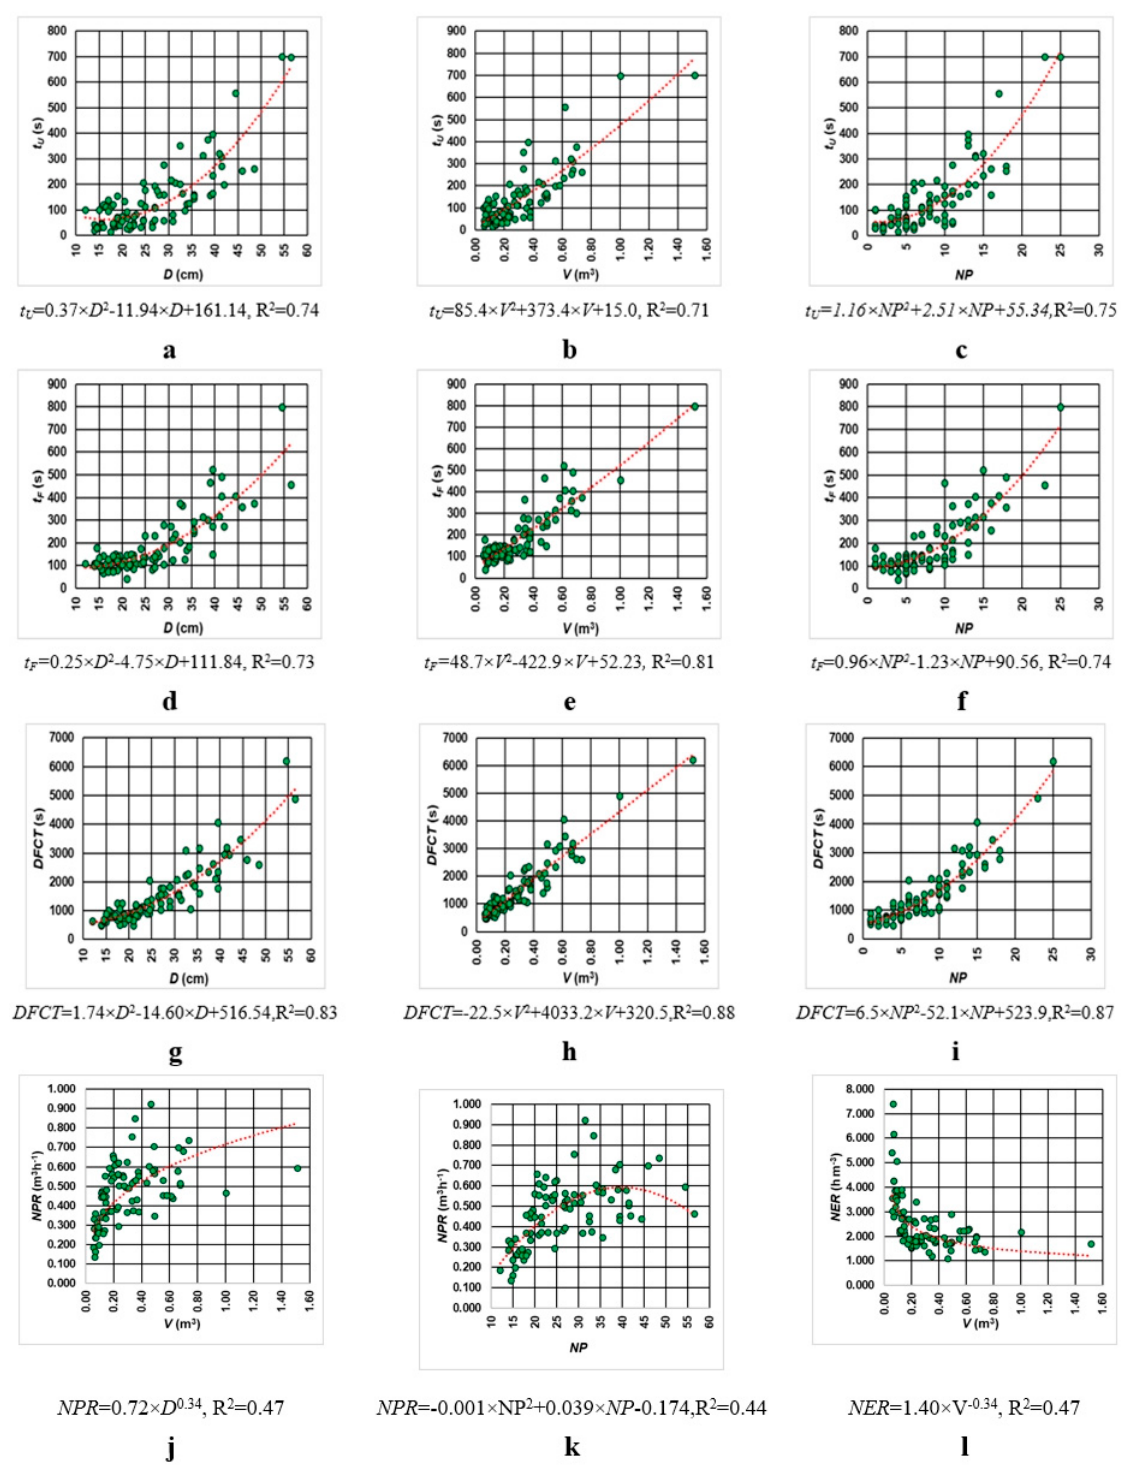
Figure 4. Time consumption and productive performance models. Legend: ( a – c )—time consumption models of the lumber unloading ( tU ) as a function of the average log diameter ( D ), log volume ( V ) and number of produced pieces ( NP ); ( d – f )—time consumption models of the lumber fixing ( tF ) as a function of the average log diameter ( D ), log volume ( V ) and number of produced pieces ( NP ); ( g – i )—delay-free cycle time models ( DFCT ) as a function of the average log diameter ( D ), log volume ( V ) and number of produced pieces ( NP ); ( j , k )—net productivity rate models as a function of average diameter of the log ( D ) and number of produced pieces ( NP ); ( l )—net efficiency rate model ( NER ) as a function of the log volume ( V